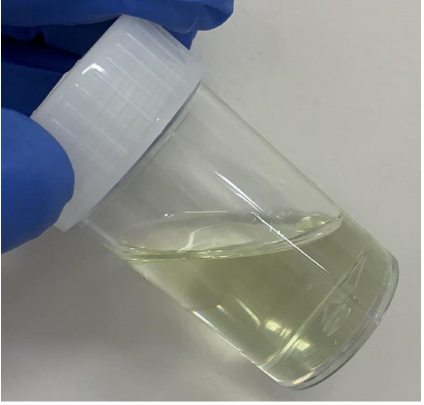
Figure 2. Binary PS80/P407 mixed